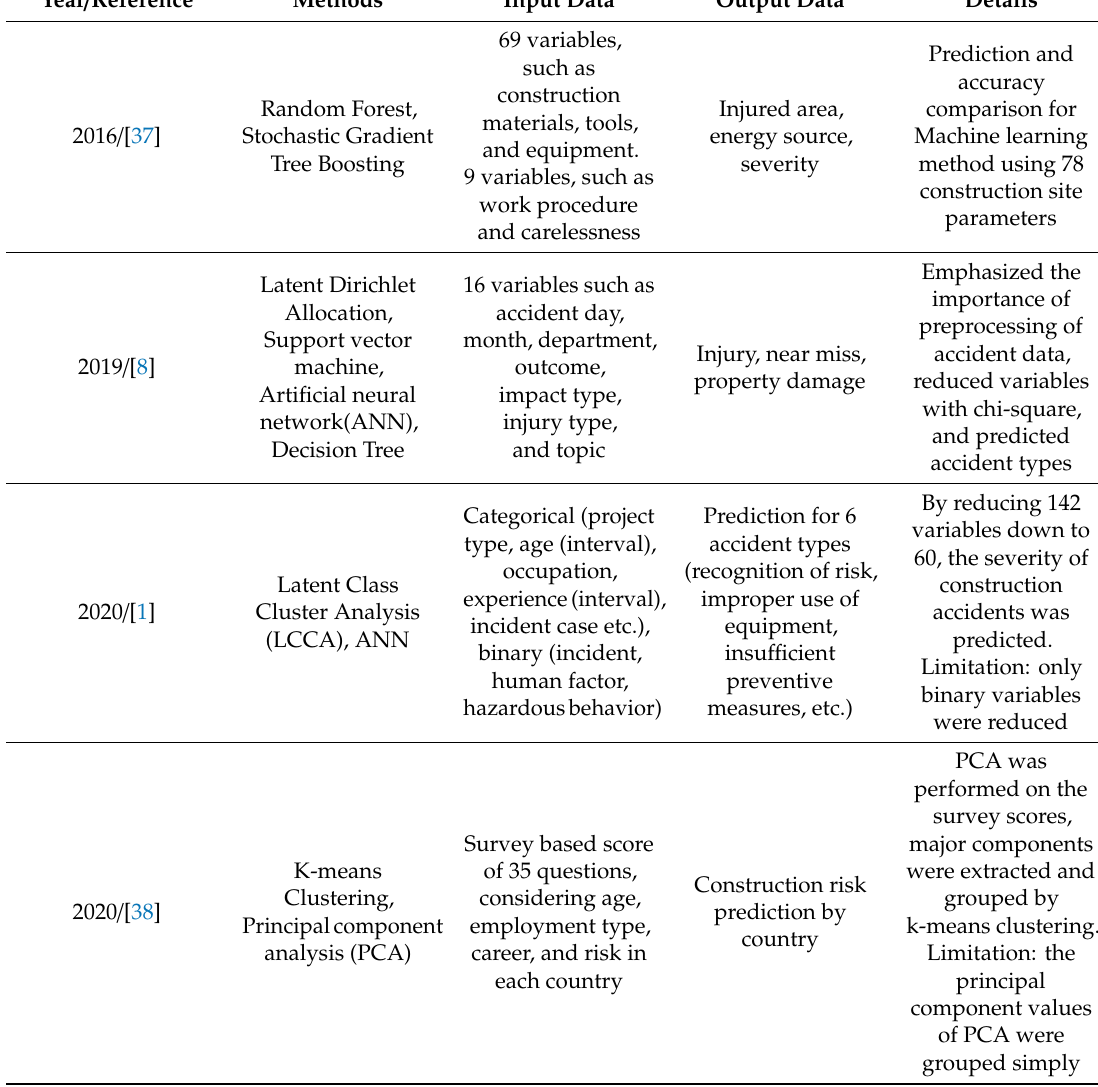
Table 1. Examples of studies utilizing occupational accident data in construction